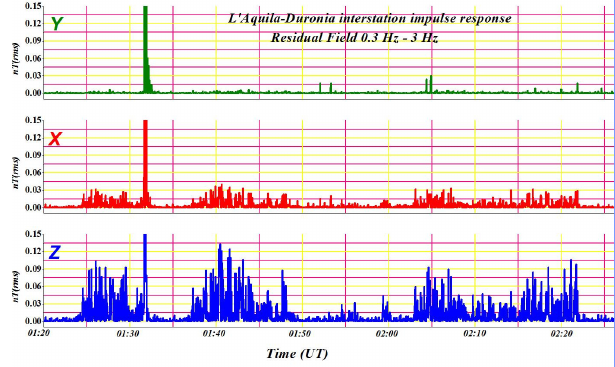
Fig. 7. RMS representation of the residual field in the frequency band from 0.3 to 3Hz. Fig. 7 RMS representation of the residual field in the frequency band from 0.3 to 3 Hz. The arrows show the large magnetic signals due to mechanical vibration of the sensors during the main phase of the earthquake.